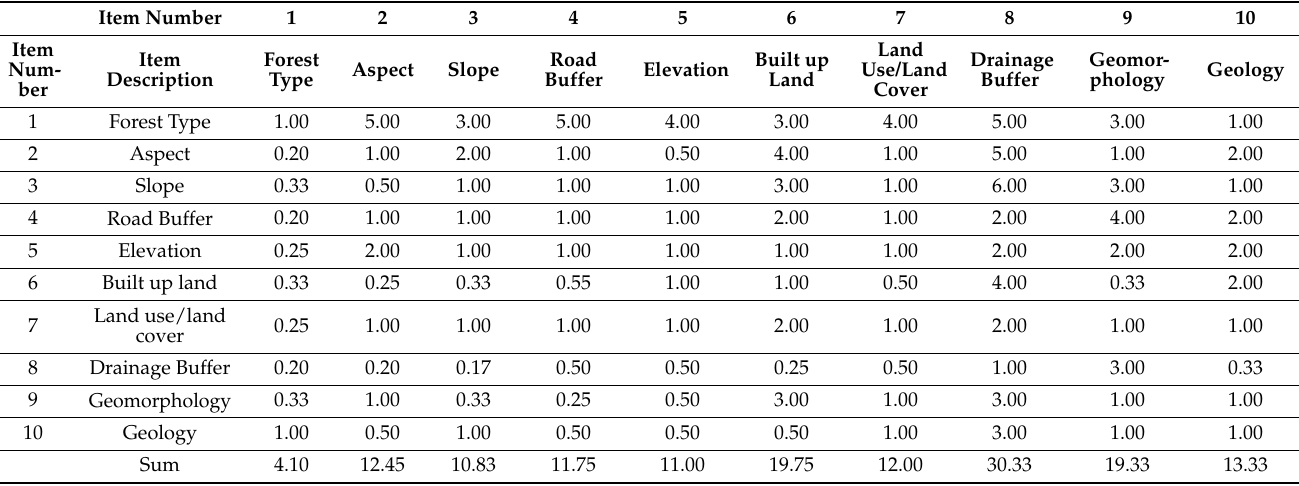
Table 3. Pairwise comparisons.